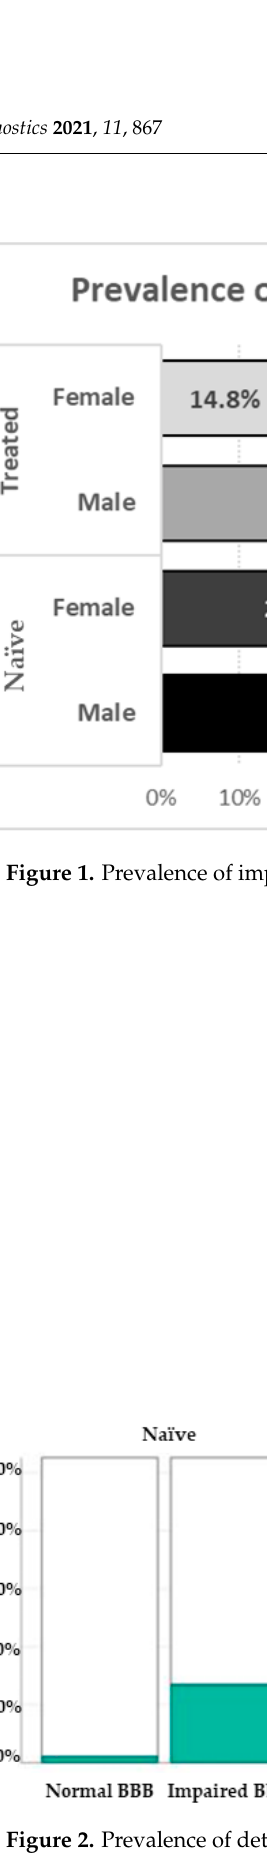
Figure 2. Prevalence of detectable CMV ( left , green bars) and EBV ( right , red bars). DNA in the cerebrospinal fluid of study participants according to blood–brain barrier integrity and treatment status.